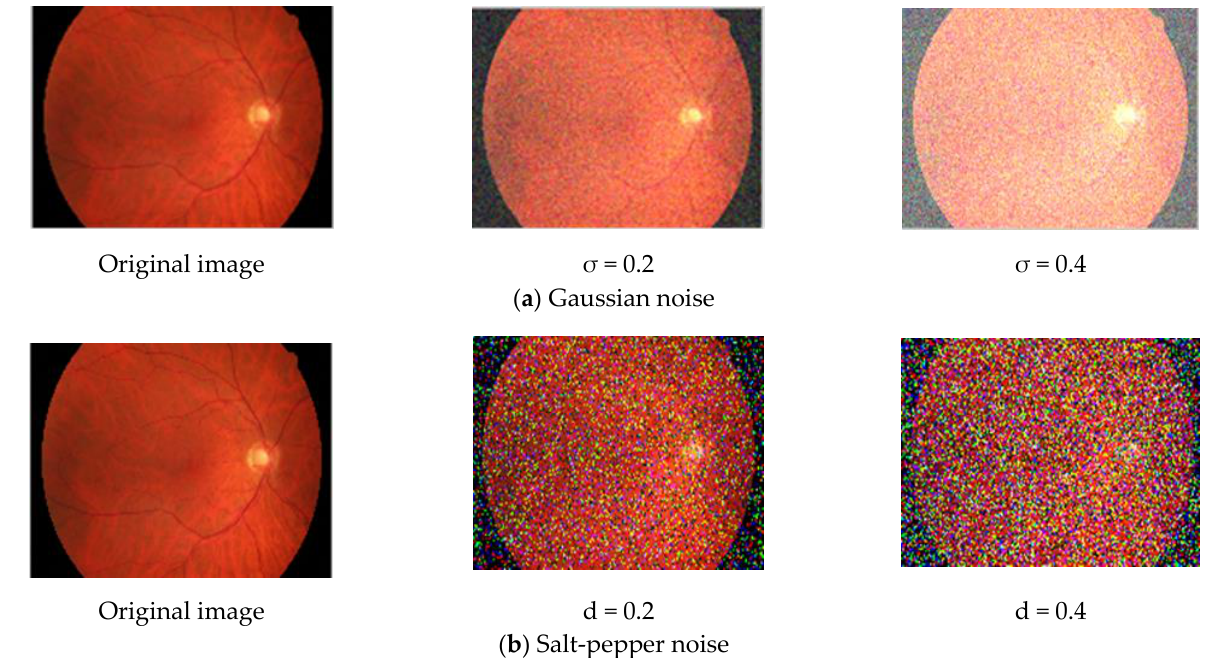
Table 11. Comparison of proposed work.